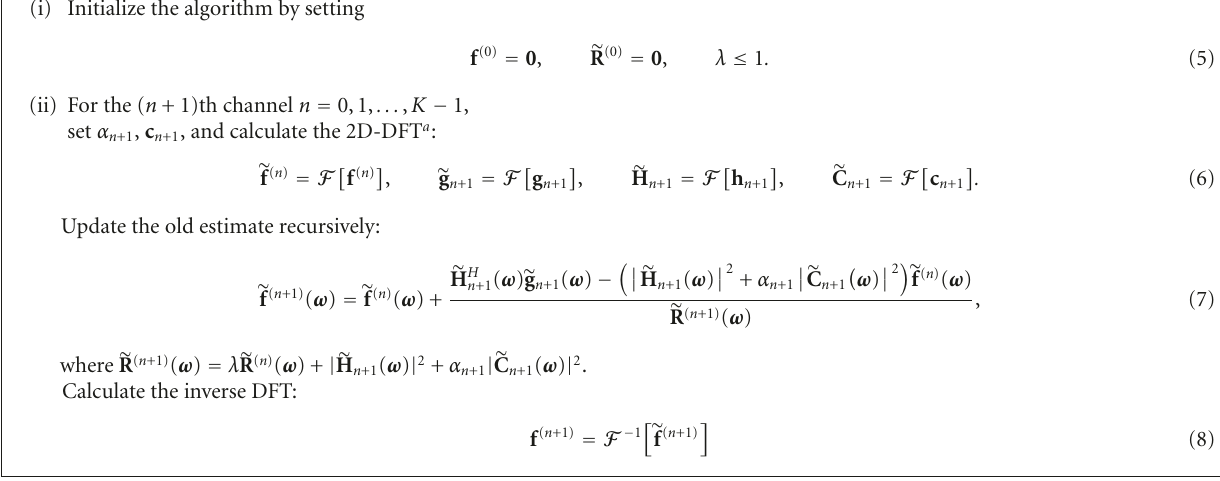
Algorithm 1: Summary of the multichannel recursive filtering for image